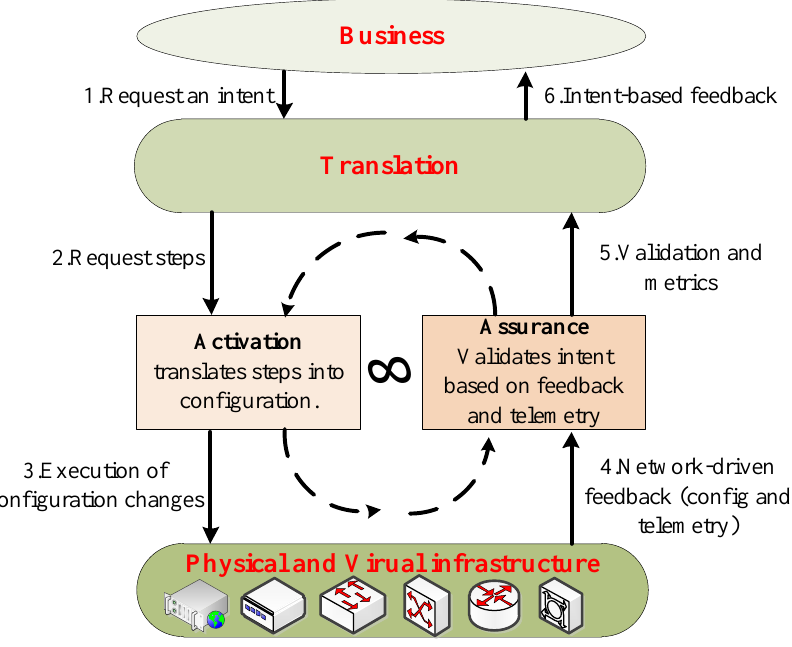
Figure 2. The concept of Intent-Based Networking.